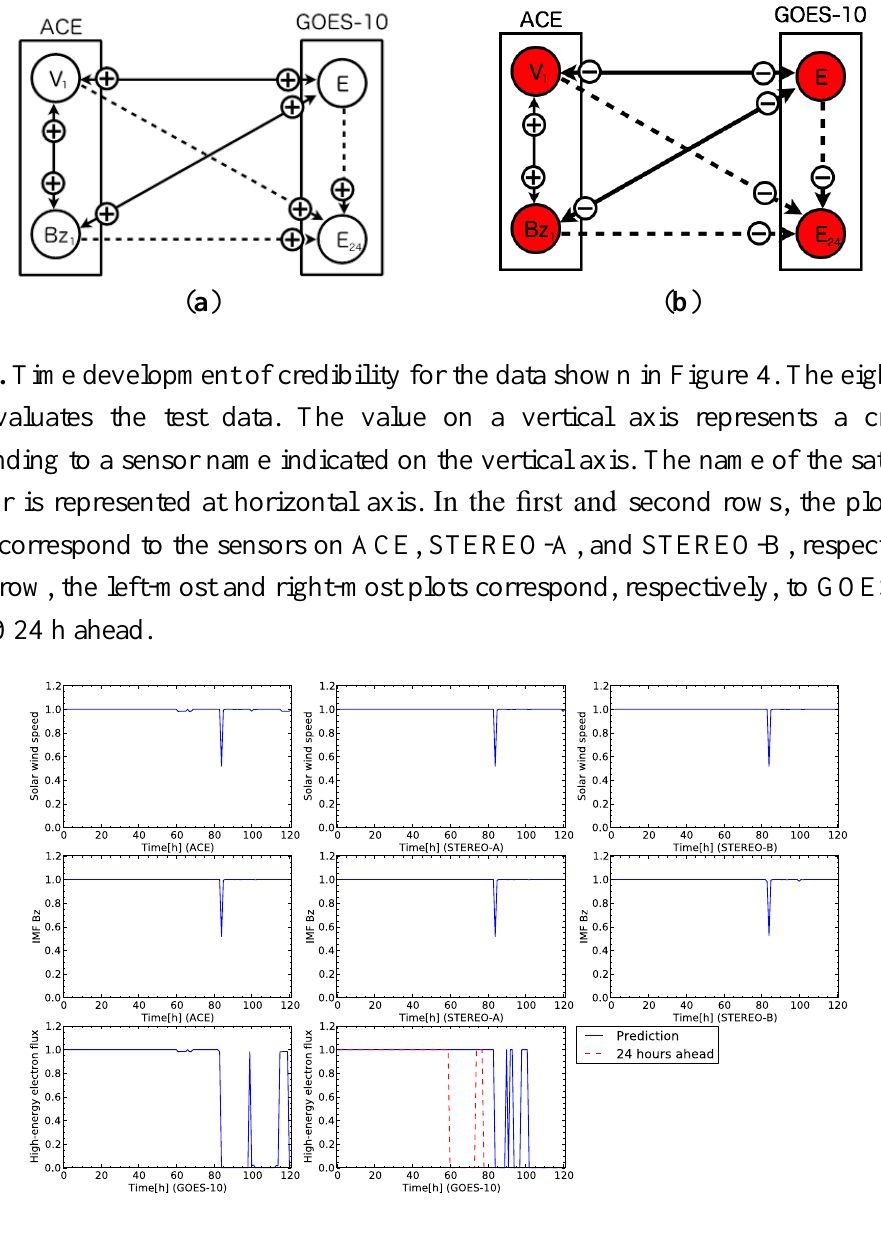
Figure 7. Snapshot of nodes in the dynamic relational network (four-sensor model). The nodes evaluated as faulty from all sensors are colored red. The nodes evaluated as faulty from half nodes are also colored red. Rectangles represent regions of satellites equipped with sensors for observation. The plus and minus signs on arcs represent a diagnosis result (plus = normal/minus = abnormal). The solid lines indicate two nodes diagnose each other. The dashed lines indicate unidirectional diagnosis from one node to another one. The symbol V and B respectively represent solar wind speed and 1 z1 north-south component of interplanetary magnetic field. The symbol E and E respectively 24 represent high-energy electron flux and its 24 h ahead. ( a ) Initial state (Step = 0); ( b ) Step = 84.